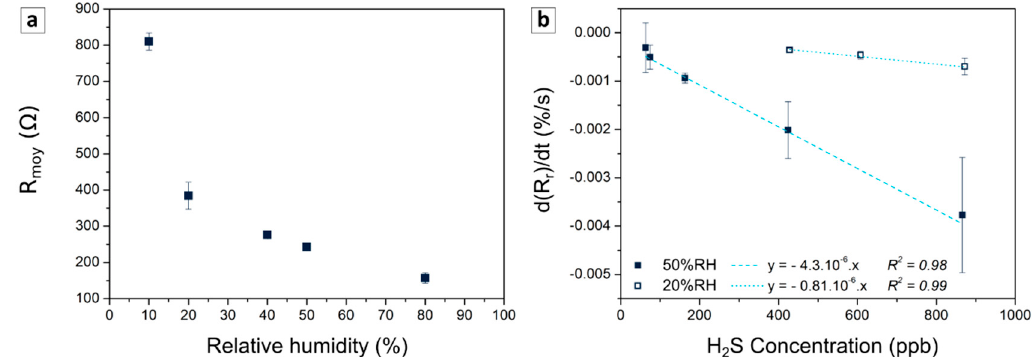
Figure 8. Impact of the humidity on the resistance of a sensor based on composite with 3 wt% of PEDOT:PSS under zero air ( a ). Impact of the humidity on the calibration curve expressed as the variation of the derivative as a function of the concentration of hydrogen sulphide at 50% and 20% of relative humidity ( b ).